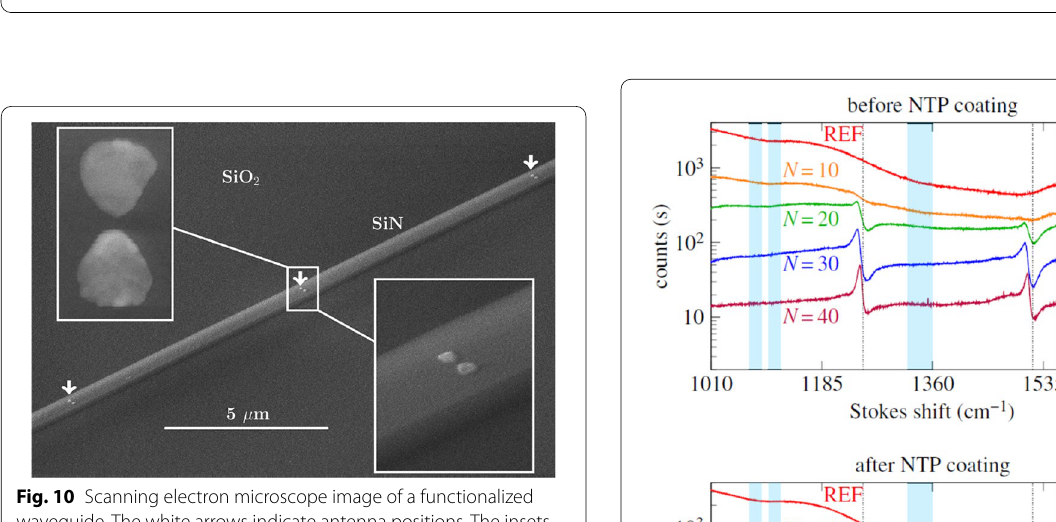
Fig. 9 a 4-NTP SERS signal acquired through the waveguide (solid blue) and the Si 3 N 4 background spectrum on a blank reference waveguide (dashed green). The 1339 cm − 1 is used for quantifying the enhancement factor. The inset shows a characteristic peak for our Si 3 N 4 at 2330 cm − 1 . b Waveguide collected SERS spectrum (solid blue) after subtracting the Si 3 N 4 background and scaling with the coupling losses, compared to a free-space collected SERS spectrum (dashed red) acquired on the same nanotriangle section. c SERS substrate-EF (SSEF) for free-space excitation and collection compared to the signal strength using a waveguide-based measurement, acquired on multiple waveguides on two different chips. (Reprinted with permission from Ref. [59])